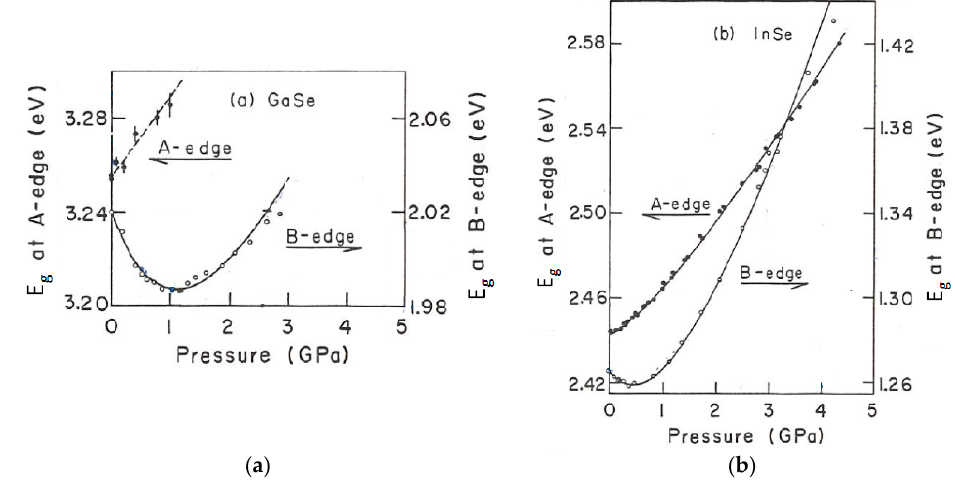
Figure 7. Pressure dependence of the fundamental absorption edge (B-edge) and the second direct transition (A-edge) in GaSe ( a ) and InSe ( b ) [25].